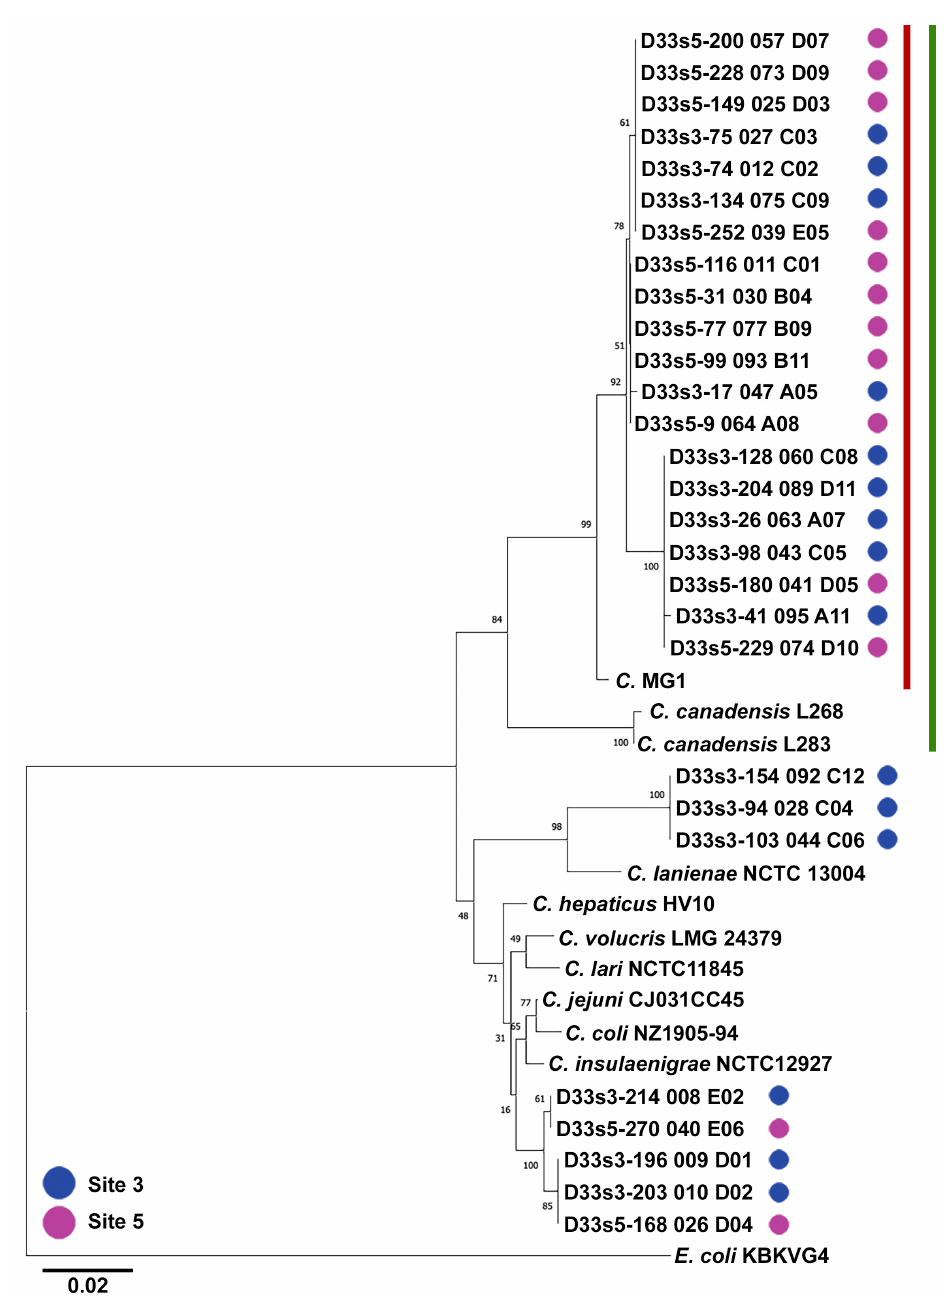
Figure 1. Phylogenetic analysis of Campylobacter 16s sequences isolated from Banklick Creek Wetlands site 3 (blue dots) and 5 (purple dots). The neighbor-joining phylogenetic tree is based on nucleotide alignments of 38 sequences composed of 661 nucleotide positions. The optimal tree is shown and drawn to scale in units of the number of base substitutions per site (scale bar = 0.02 substitutions). The percentage of replicate trees in which the associated taxa clustered together in the bootstrap test (500 replicates) are shown next to the branches. E. coli (strain KBKVG4) was used to root the tree. The majority of sequenced isolates clustered within a clade containing MG1 (red vertical line). The closest outgroup for the MG1-containing clade was occupied by C. canadensis (green vertical line).